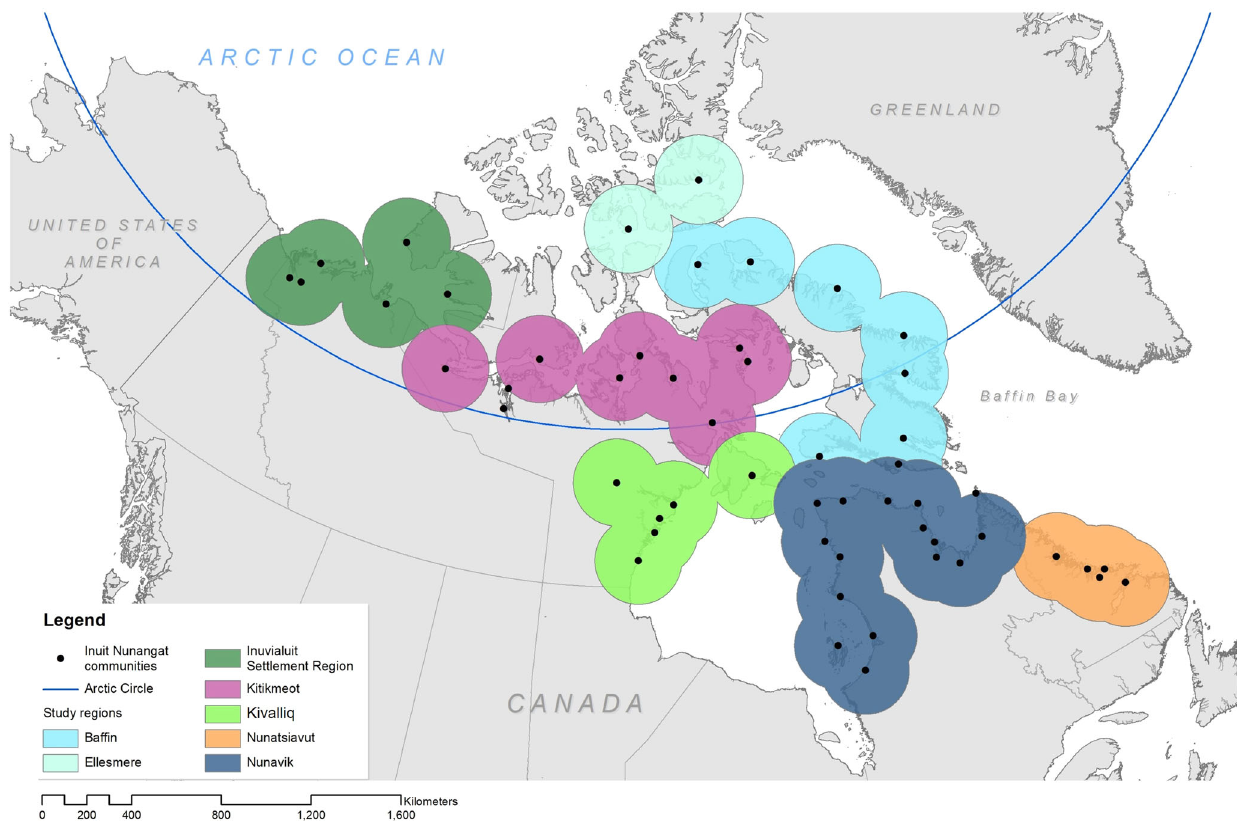
Fig. 1 Inuit Nunangat (the Inuit homeland). The region is home to approximately 56,000 people, inhabiting 53 mostly coastal communities. We examine trail access trends across 7 geographic regions, aggregating from analyses focusing on projected climatic and ice trends within a 100 km (climate) to 150 km (ice) radius of each community. The 150 km radius ice areas are shown